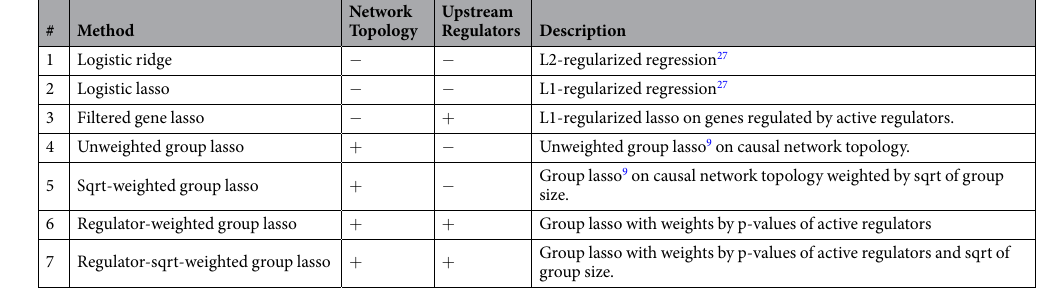
Table 1. Comparison of classification methods evaluated on simulated and clinical